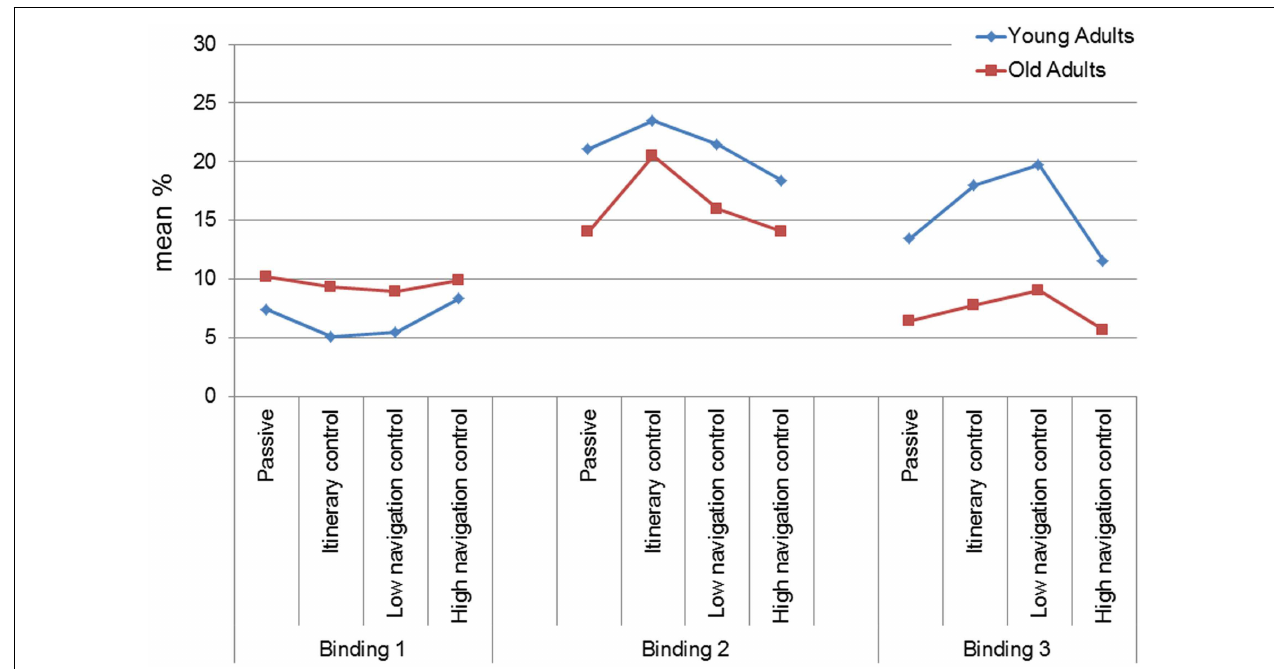
FIGURE 3 | Main effects of condition (mean and standard deviation) for the mean immediate and delayed binding score in theVR–EM test according to the level of binding and age-group .